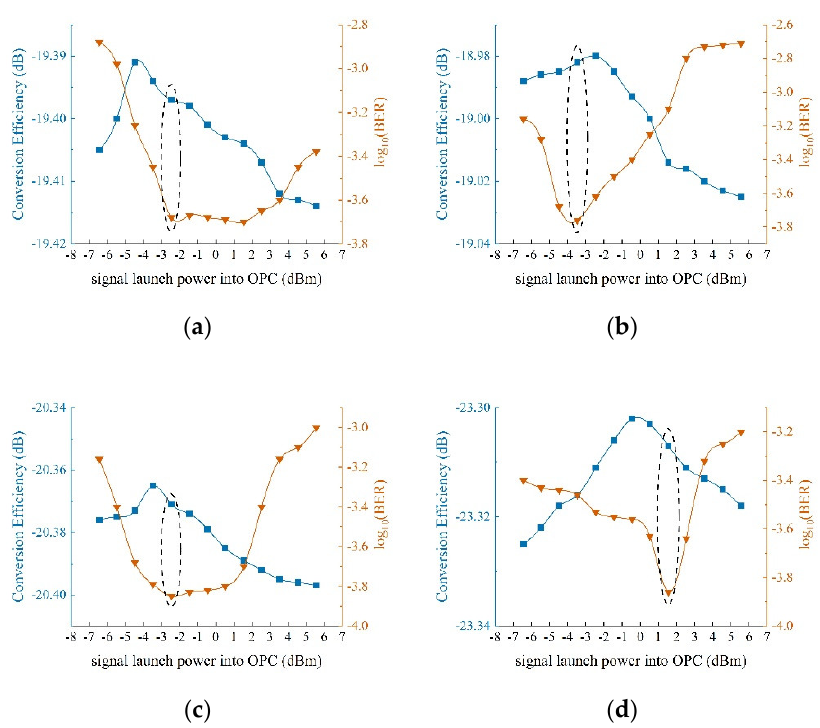
Figure 2. Measured conversion efficiency in square symbol line and bit error rates (BERs) in triangle symbol line versus the signal power input into OPC. ( a ) HNLF A; ( b ) HNLF B; ( c ) HNLF C; ( d ) HNLF D.